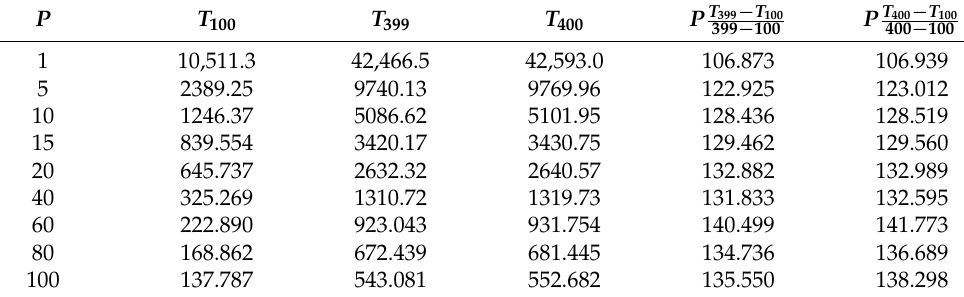
Figure 30. Parallel efficiency of the third-order solver for solving Problem 6. Table 2. Time costs of the third-order solver running on different numbers of cores.